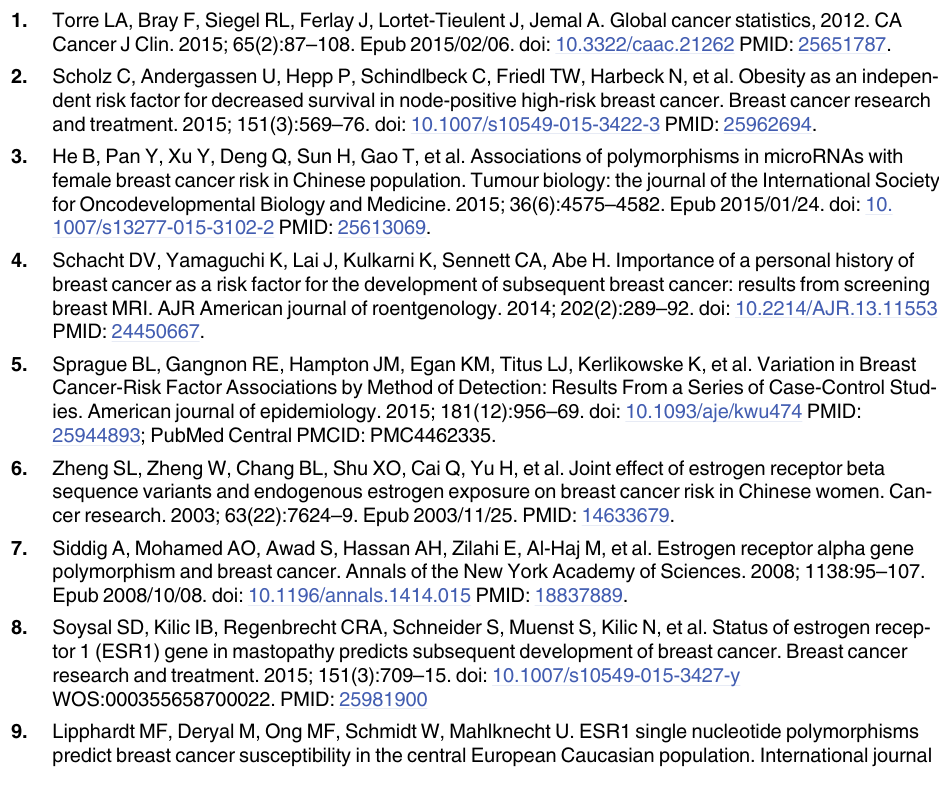
S3 Table. Detailed genotype and allele frequency information. S4 Table. Detailed information for SNP rs2077647 in the four different models. S5 Table. Detailed information for SNP rs2228480 in the four different models. S6 Table. Detailed information for SNP rs3798577 in the four different models. S7 Table. Characteristics of the studies included in the meta-analysis of the three